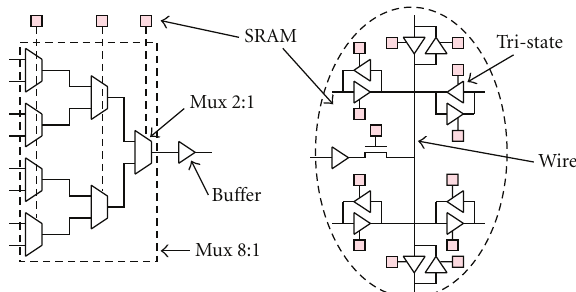
Figure 3: Unidirectional versus bidirectional wires.